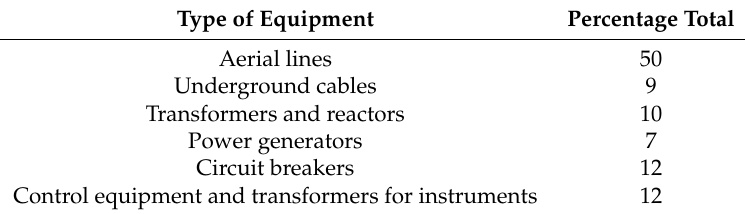
Table 1. Percentage of absences for equipment in the electric power system ( EPS